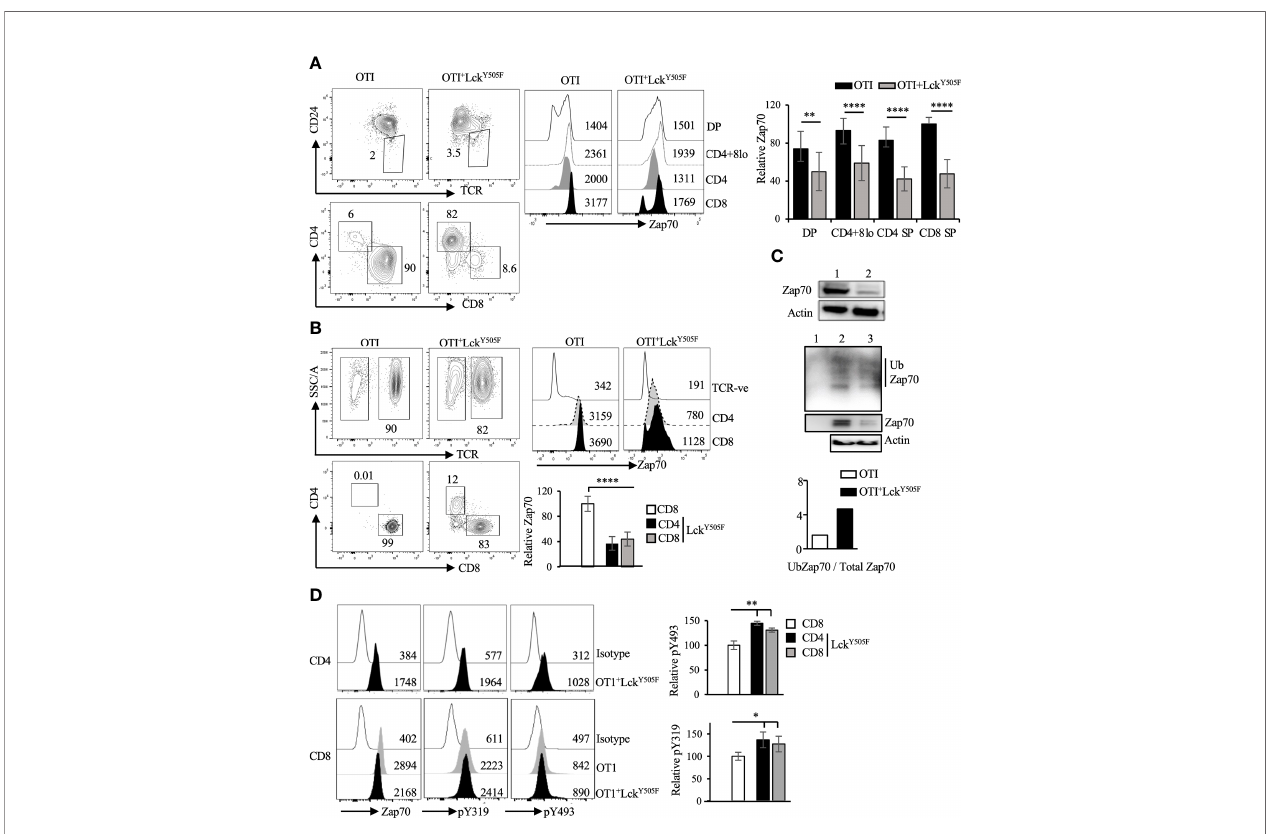
FIGURE 4 | Constitutively active Lck results in Zap70 diminution in vivo . (A) shows CD24/TCR staining of total thymocytes and CD4/CD8 pro fi le of mature thymocytes (CD24 lo TCR + ) from the indicated mice. Histograms show Zap70 staining and bar graph shows comparison of relative Zap70 expression in DP, CD4 + CD8 lo , CD4 + and CD8 + thymocytes from OTI mice expressing or not Lck Y505F transgene. Zap70 expression was normalized to that in CD8 + thymocytes from OTI control mice in each experiment. (B) CD4/CD8 pro fi le and Zap70 staining of CD4 and CD8 T cells from OTI mice expressing or not Lck Y505F is shown. Bar graph shows compilation of Zap70 MFI in the indicated T cell subsets from OTI and OTI + Lck Y505F mice normalized to that in CD8 T cells from OTI mice in each experiment. (C) Western blot shows a representative example of Zap70 and actin expression in total lysates of puri fi ed T cells from control (lane 1) and Lck Y505F (lane 2) expressing OTI mice. Middle panel shows anti-Ubiquitin Western blot of Zap70 immunoprecipiates of puri fi es splenic T cells from OTI (lane 2) and OTI + Lck Y505F (lane 3) mice. Lane 1 is anti-Zap70 antibody control. Total lysates was probed for actin and serves as control for cell numbers. (n=2 independent experiments). (D) Histograms for total, pY319 and pY493 Zap70 staining in CD4 and CD8 T cells from the indicated mice is shown. Bar graph shows relative pY319 and pY493 value expressed as ratio of MFI for phospho staining to total Zap70 staining for CD4 and CD8 T cells from OTI + Lck Y505F mice ( fi lled bars) and normalized to that in CD8 T cells from OTI mice (open bar). Data are representative example of 6 (A, B) or 3 (D) independent experiments. Numbers in FACS plots and histograms represent frequency of cells and MFI values * p < 0.05, ** p < 0.005, and **** p <